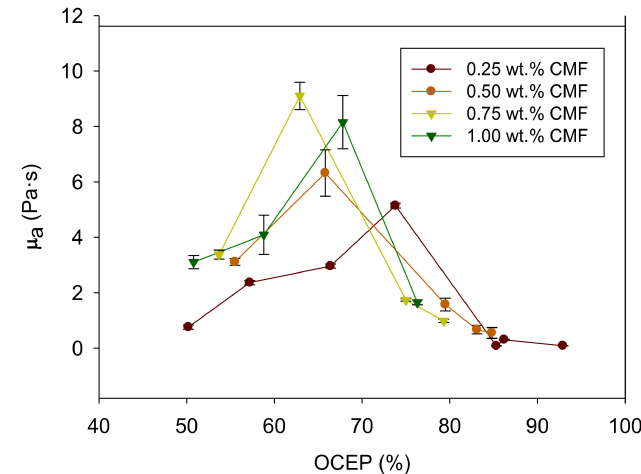
Figure 7. Effect of oil content in the emulsion phase (OCEP) on apparent viscosity for different CMF doses using 1 s − 1 as shear